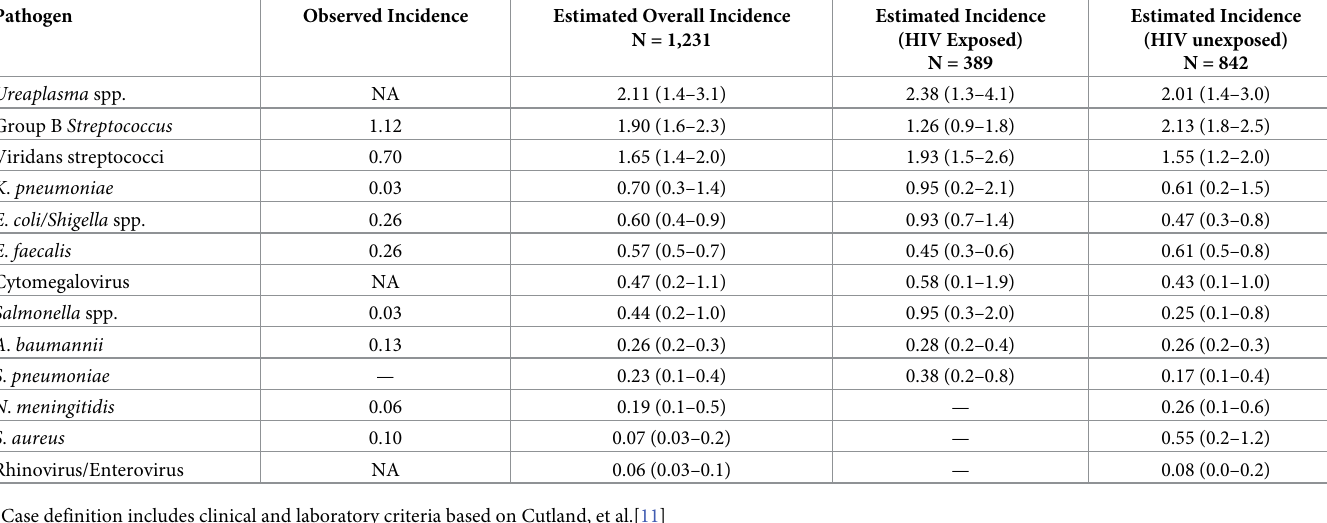
Table 7. Observed and estimated pathogen specific incidences per 1,000 live births (with 95% confidence limits) of sepsis � overall and by HIV